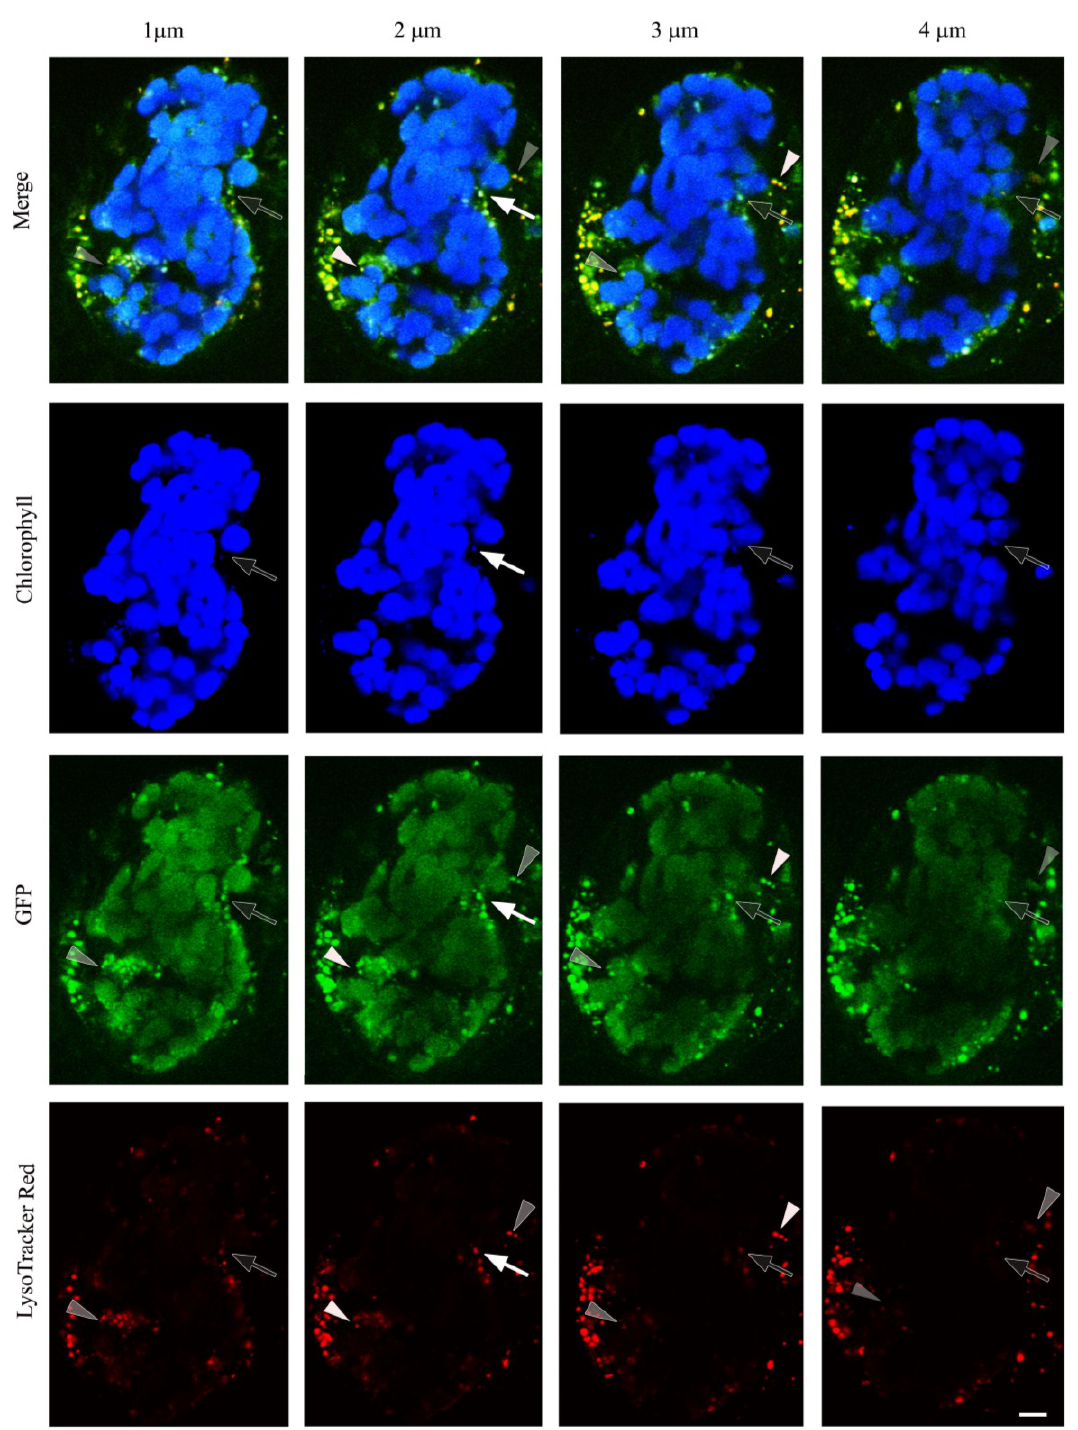
Figure 3. Z-stack (consecutive 1 µm thick optical slices) covering a depth of 4 µm in a mesophyll cell of a senescing tobacco leaf expressing GFP targeted to the plastid [61]. As an example, SAV detected in the middle planes (second or third optical slices) are indicated with white arrows (one SAV with LysoTracker Red and GFP and Chl fluorescence) or white arrowheads (two SAVs with LysoTracker Red, and GFP fluorescence). Empty arrows/arrowheads show fainter signals above or below the focal plane of selected SAVs. Note that most SAVs, stained by Lysotracker Red, also contain GFP, and that almost all GFP located outside chloroplasts is found in SAVs. Scale bar: 5 µm. Redrawn from